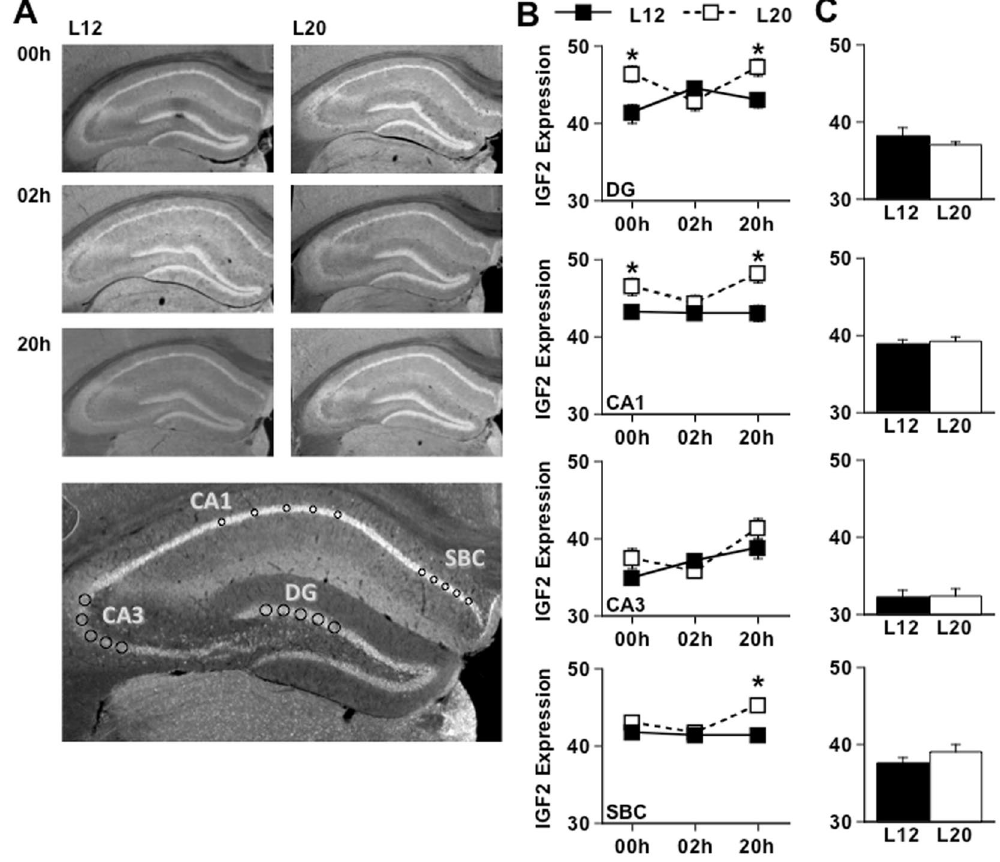
Figure 6. Long days increase IGF2 expression in the dorsal hippocampus before and after SOR training. ( A ) Representative images illustrating changes in IGF2 expression caused by long day exposure and SOR training. To measure IGF2 expression, fluorescence intensity was averaged across five regions of interest placed within the Dentate Gyrus (DG), Cornu Ammonis 1 (CA1), Cornu Ammonis 3 (CA3), and Subiculum (SBC). ( B ) L20 altered IGF2 expression in specific hippocampal subregions (Full Factorial ANOVA DG- Photoperiod: F(1,90) = 9.11, p < 0.01, Time: F(2,90) = 1.18, p > 0.3, Photoperiod * Time: F(2,90) = 6.13, p < 0.01; CA1- Photoperiod: F(1,90) = 19.63, p < 0.0001, Time: F(2,90) = 2.31, p > 0.1, Photoperiod * Time: F(2,90) = 1.95, p > 0.1; CA3- Photoperiod: F(1,90) = 0.14, p > 0.1, Time: F(2,90) = 7.95, p < 0.01, Photoperiod * Time: F(2,90) = 2.20, p > 0.1; SBC- Photoperiod: F(1,90) = 9.31, p < 0.01, Time: F(2,90) = 2.92, p = 0.06, Photoperiod * Time: F(2,90) = 3.17, p < 0.05. * L12 versus L20, LS Means Contrasts, p < 0.05. C . IGF2 expression in the hippocampus did not differ between untrained L12 and L20 mice analyzed at the time equivalent to 20 h after SOR training (Student’s t test DG- t(1,30) = 0.68, p > 0.5; CA1- t(1,30) = − 1.79, p > 0.05; CA3- t(1,30) = − 0.24, p > 0.5; SBC- t(1,30) = − 1.23, p >